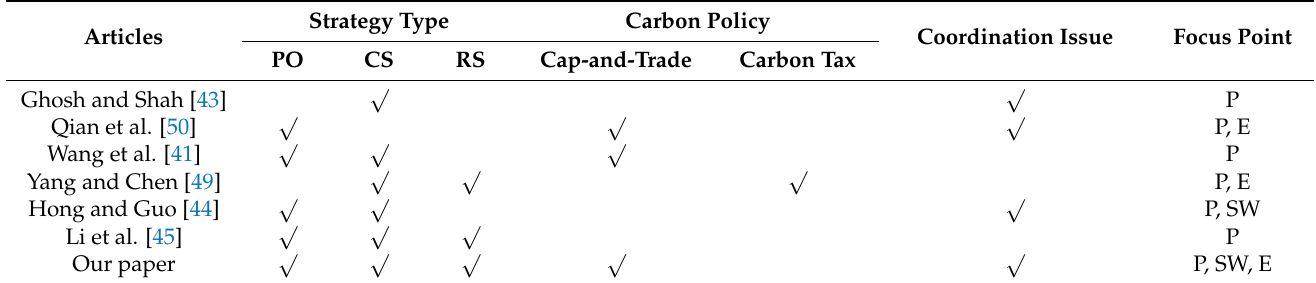
Table 1. Main differences between our work and the relevant research.